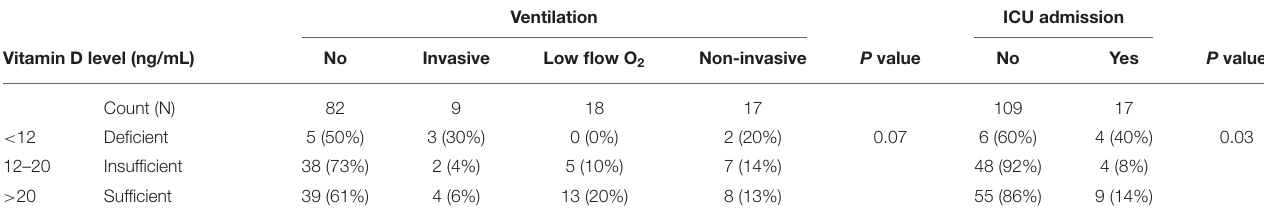
TABLE 2 | Association between serum vitamin D levels to ventilation, ICU